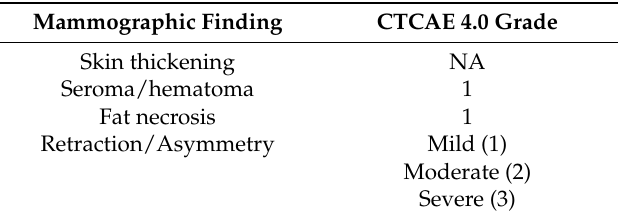
Table 2. Mammographic findings at the six-month follow-up visit.